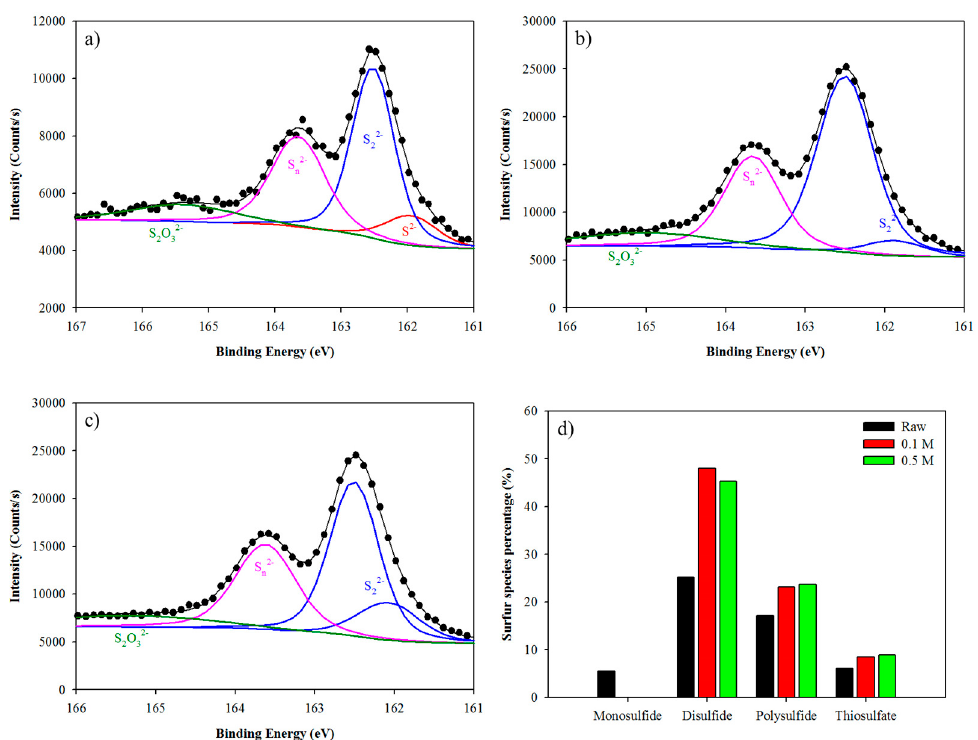
Figure 10 . XPS spectra of S2p for ( a ) raw concentrate, ( b ) leach residue (0.1 M), ( c ) leach residue (0.5 M), and ( d ) distribution of the surface S species. The leaching conditions were 80 °C and 15 min.